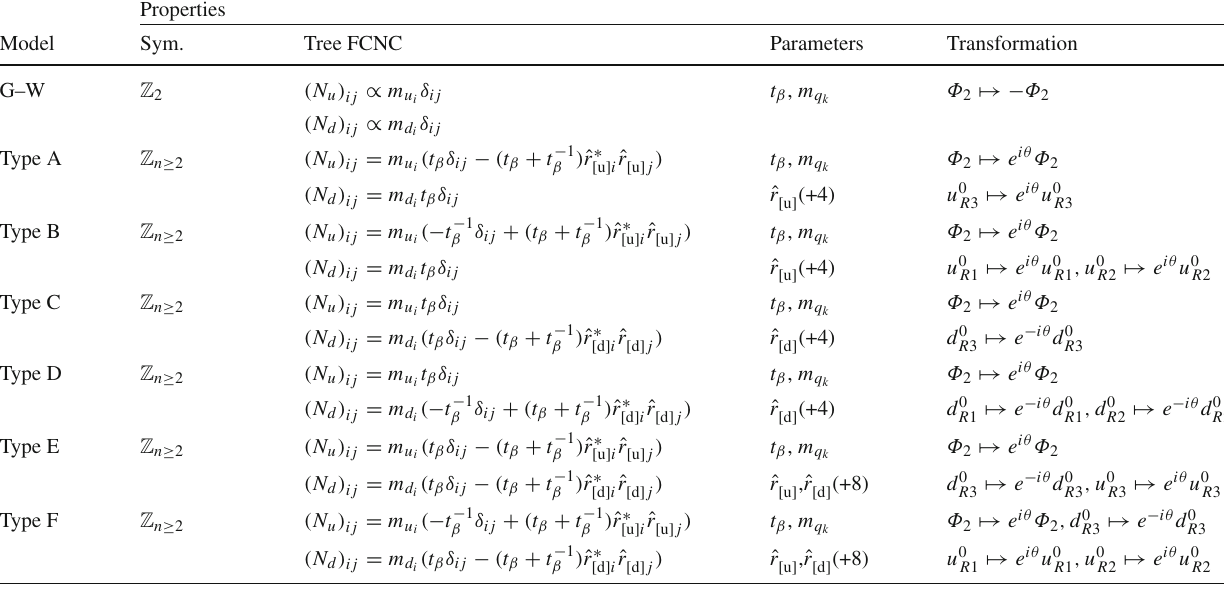
Table 1 Models obeying Right conditions , Eq.(49). As in Table 2, the first row shows Glashow–Weinberg models without tree level FCNC for comparison. In the “Parameters” column, (+4) or (+8) is the number of new parameters associated to ˆ r [ q ] Properties